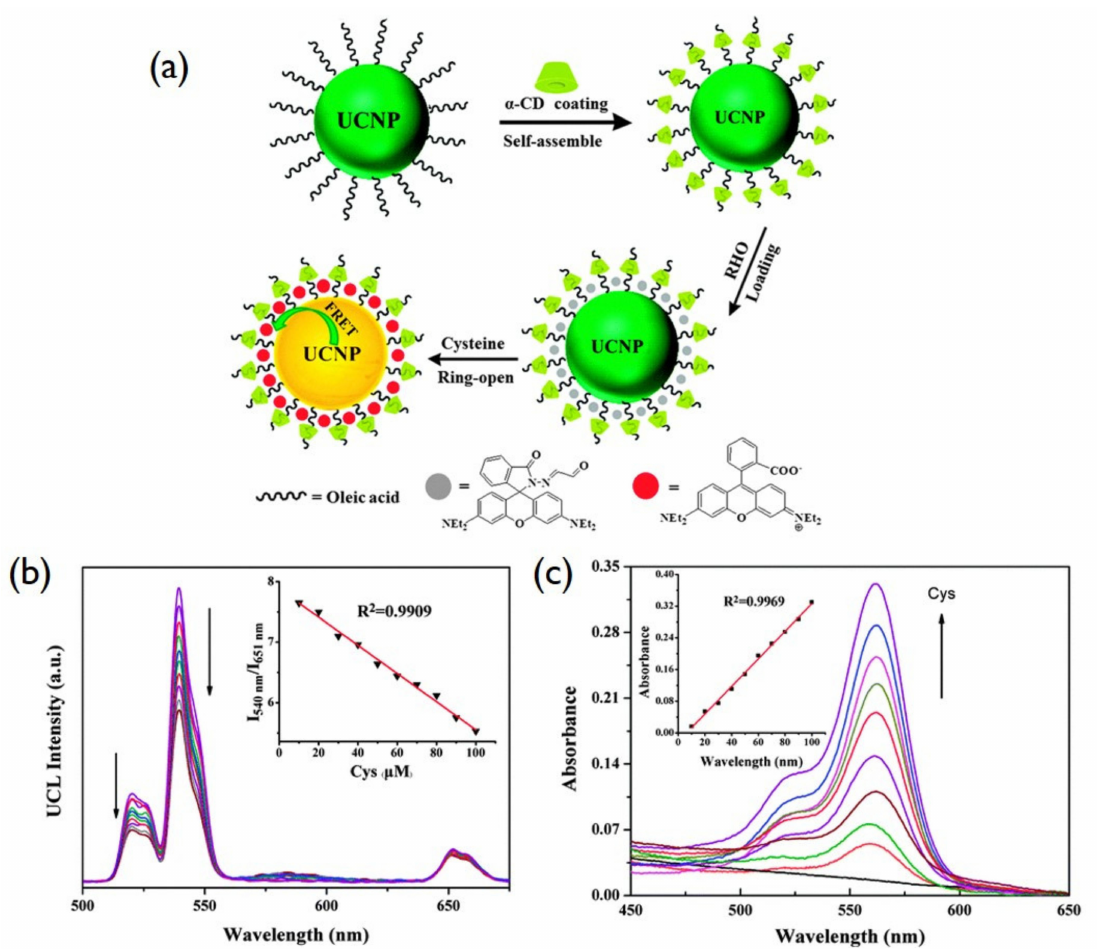
Figure 7. ( a ) Schematic description of the UCNP surface modification and FRET based on donor UCNPs and acceptor rhodamine. ( b ) UC emission spectra under 980 nm, (Inset: the variation of relative UC emission intensity at a 540 nm to 651 nm ratio upon different amount of Cys. ( c ) UV–Vis absorption titration spectra (Inset: the linear response of the absorption peak intensity at 562 nm and Cys concentration) of RHO functionalized UCNPs with a gradual increment of Cys. Reproduced with permission from